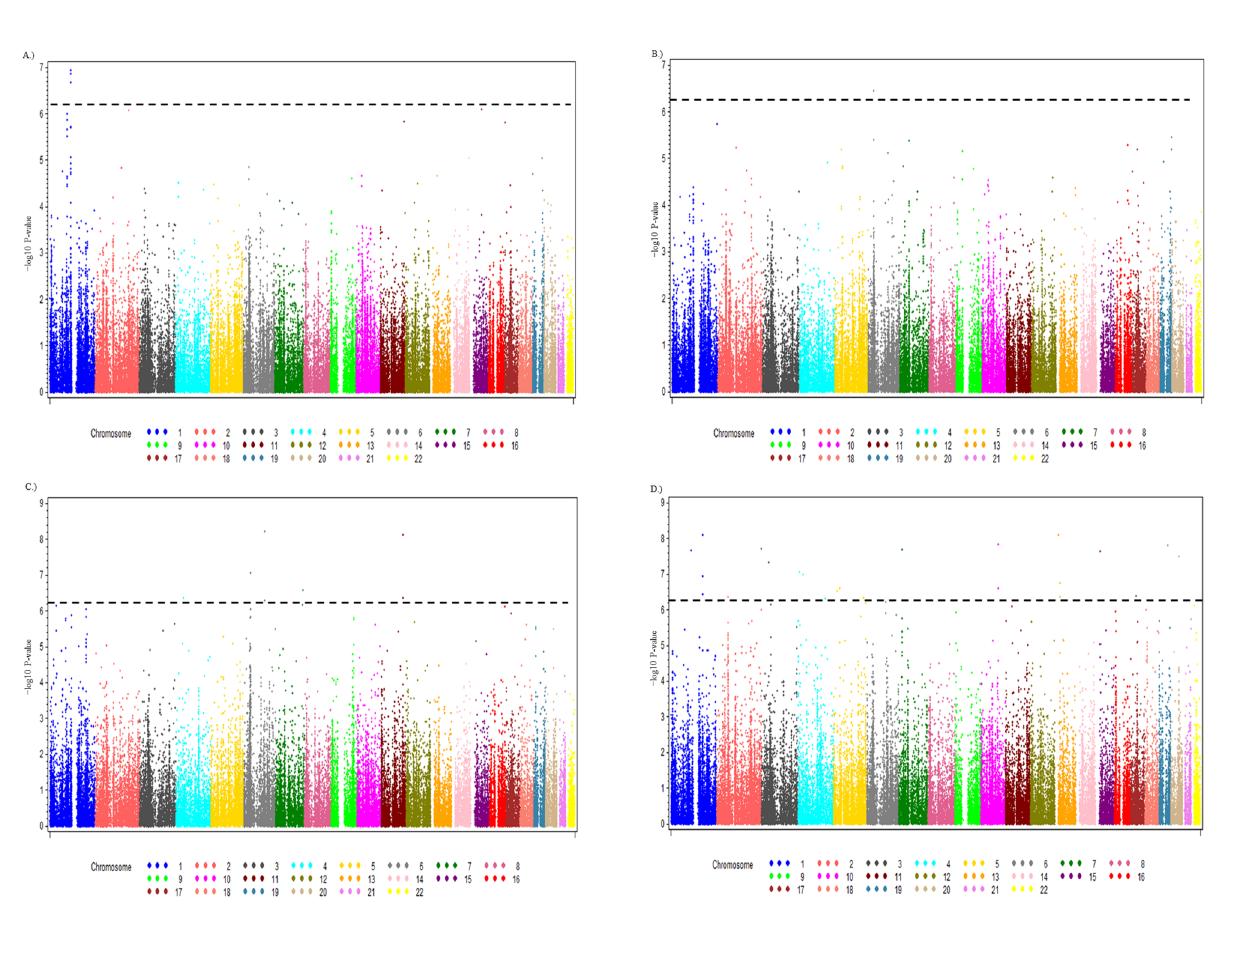
Figure 1. Manhattan plot showing the association P-values of single nucleotide polymorphisms (SNPs) in the ImmunoChip with the time to clearance of HR-HPV. The X-axes display the chromosome on which the SNP is located, the Y-axes display 2 log 10 P-value. The dashed black line represents a significance level needed for multiple testing using the K effective method. Panel A.) Race-adjusted analysis B.) African Americans only C.) European Americans only, and D.) Hispanics only.